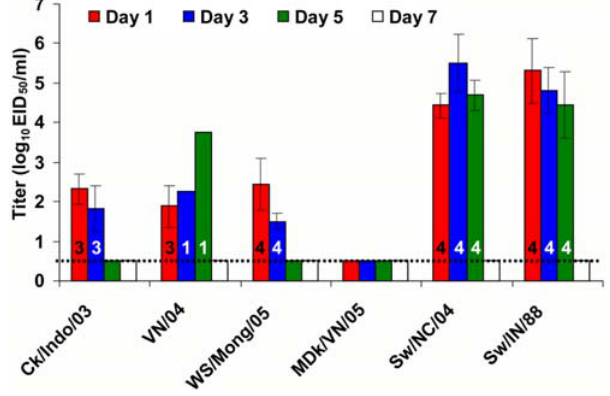
Figure 3. Virus titer in nasal swabs of pigs during influenza virus infection. Each data point represents the mean 6 SD virus titer ( log 10 EID 50 /ml of sample media ) from pigs positive for influenza virus. Numbers of pigs sheding virus (of 4) are shown in each bar. The lower virus detection limit is 10 0.5 EID 50 /ml.